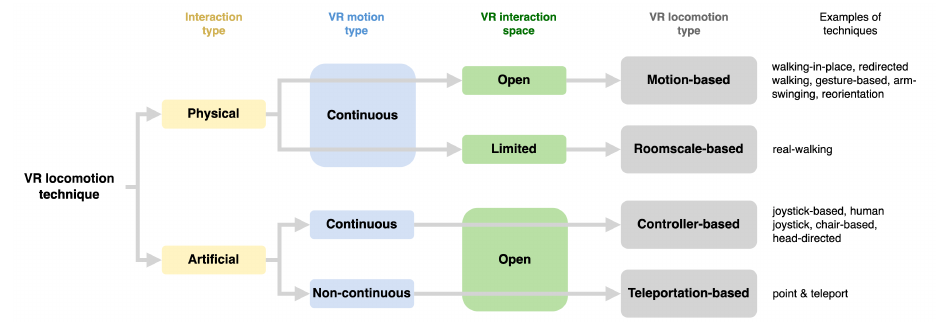
Figure 1. The VR locomotion typology, as presented in